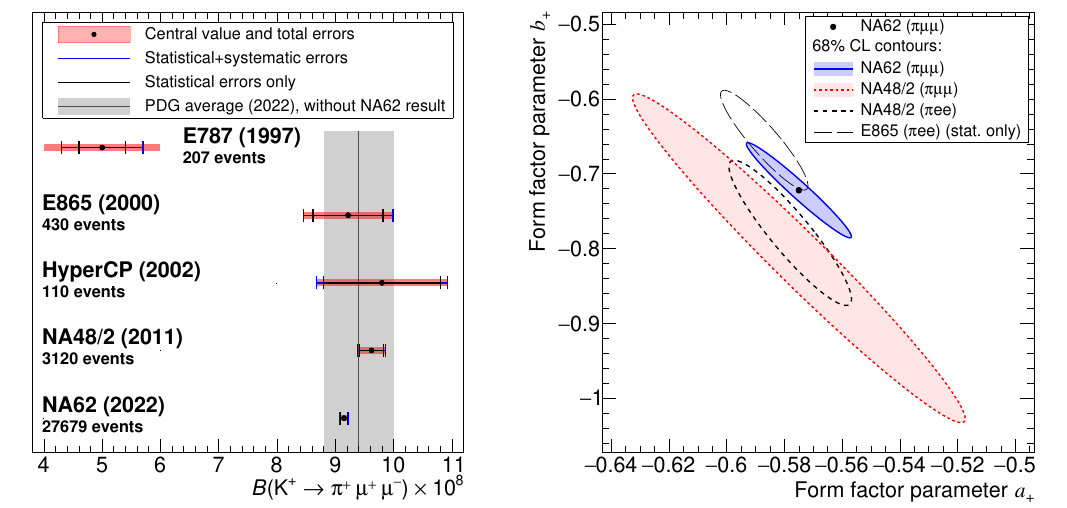
Figure 5 . Comparison with earlier measurements. Left: the K πµµ branching fraction, with the PDG [22] average shown as a shaded band. Right: combined statistical and systematic 68% CL contours in the ( a ) plane for the muon and electron modes. The NA48/2 value of ρ ( a + , b + the electron mode is used to construct the E865 contour, as E865 [14] does not quote the correlation. The systematic uncertainties in a and b are not provided by E865 [14]. + +